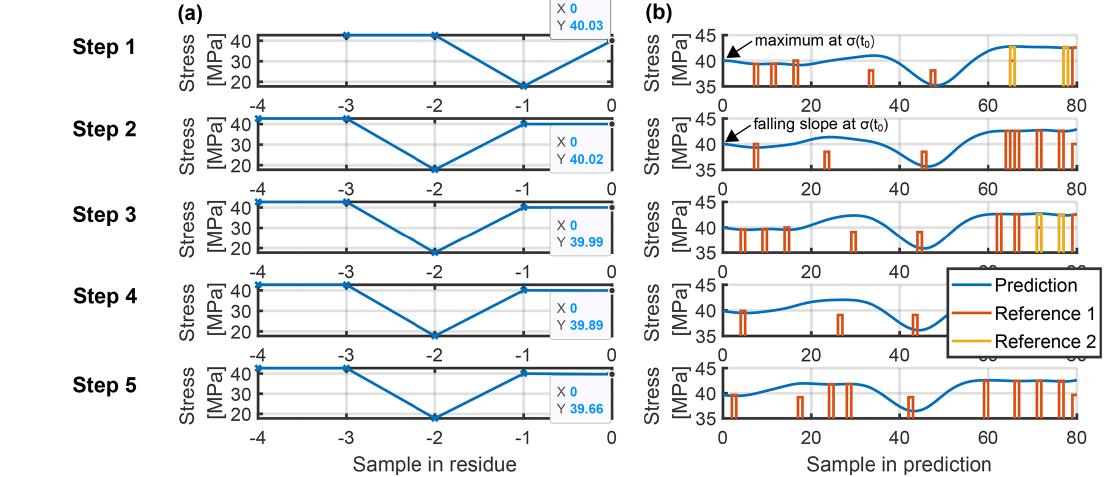
Figure 15. Stress trajectories for PORFC-2R in turbulent wind 10s after the start of the simulation. Top-down: five consecutive MPC steps. Residue set of variable size, in which the values of the last stress samples are labeled (a) . Stress prediction of the MPC and stress references as part of the PORFC parameter set (b)